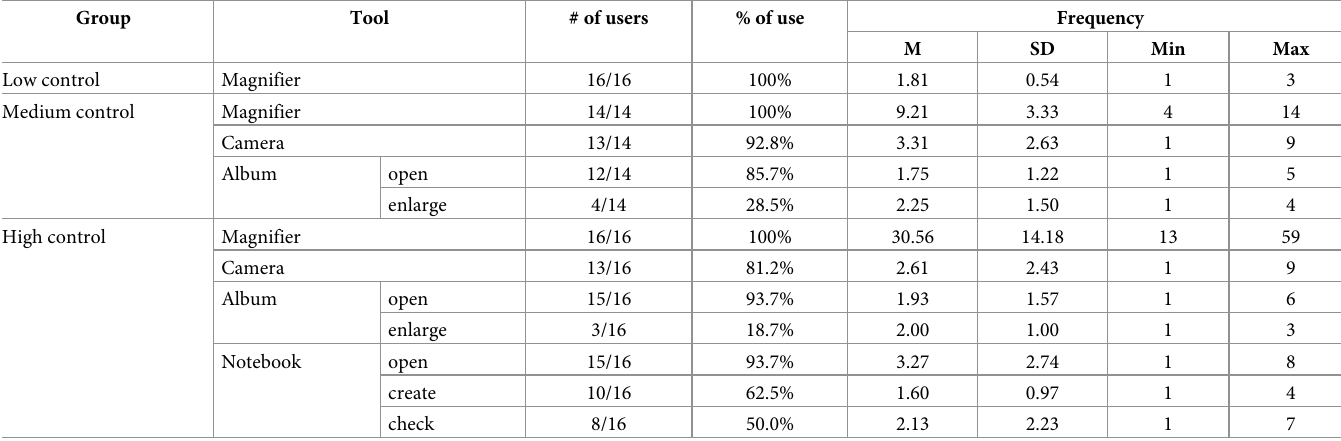
Table 8. Number and frequency of AR tool usage.